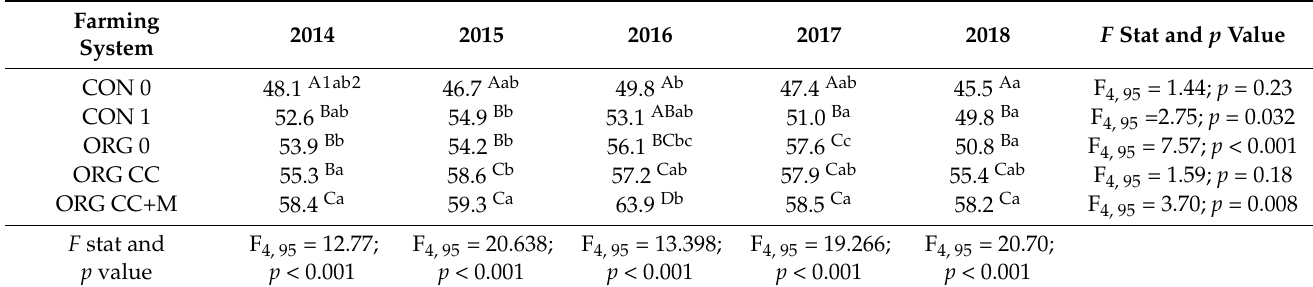
Table 5. The hydrolytic activity of soil microorganisms ( µ g fluorescein g − 1 soil dry weight h − 1 ) during